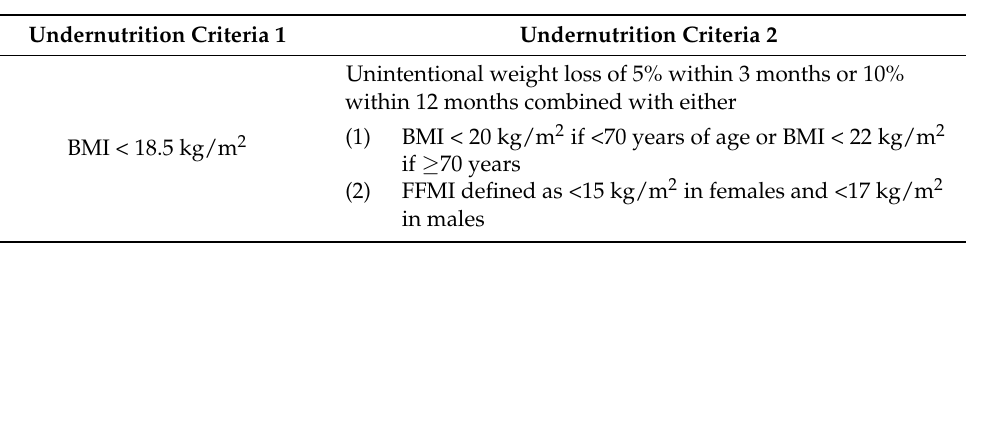
Table 1. Diagnostic criteria for undernutrition by the European Society for Clinical Nutrition and Metabolism.